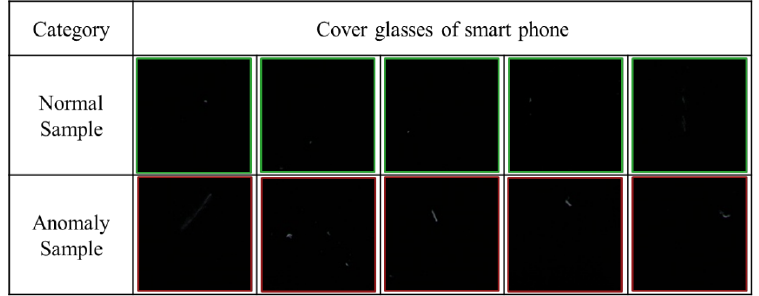
Figure 5. Production line mobile phone screen glass dataset.